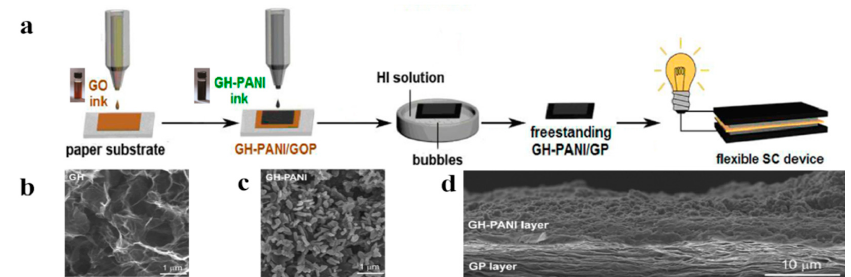
Figure 14. ( a ) Fully printed process for making a paper-based supercapacitor; ( b ) Graphene hydrogel (GH) with a porous network; ( c ) Coral-like nano-polyaniline (PANI) grown on graphene hydrogels; ( d ) Stacked stacks of graphene paper and nanocomposites. Reproduced from [92], with permission from American Chemical Society, 2014.